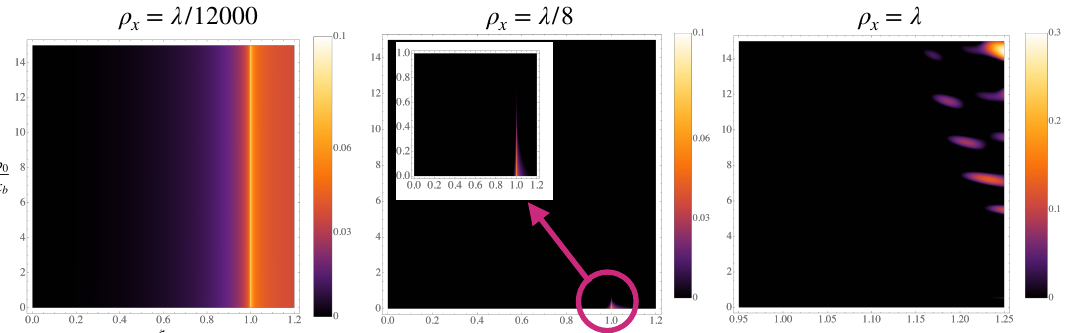
Figure 1. Concurrence vs. the light-cone parameter ε x and the wormhole parameter ε b for three different qubit distances and K = 7.5 · 10 − 3 . For the shortest distance ( left ), the effect of the presence of the analogue wormhole is mostly irrelevant. For medium distances ( middle ), entanglement appears in the flat-spacetime case and quickly vanishes as b 0 grows (see the inset). For larger distances ( right ), we find the opposite scenario: There is entanglement only in the presence of the effective